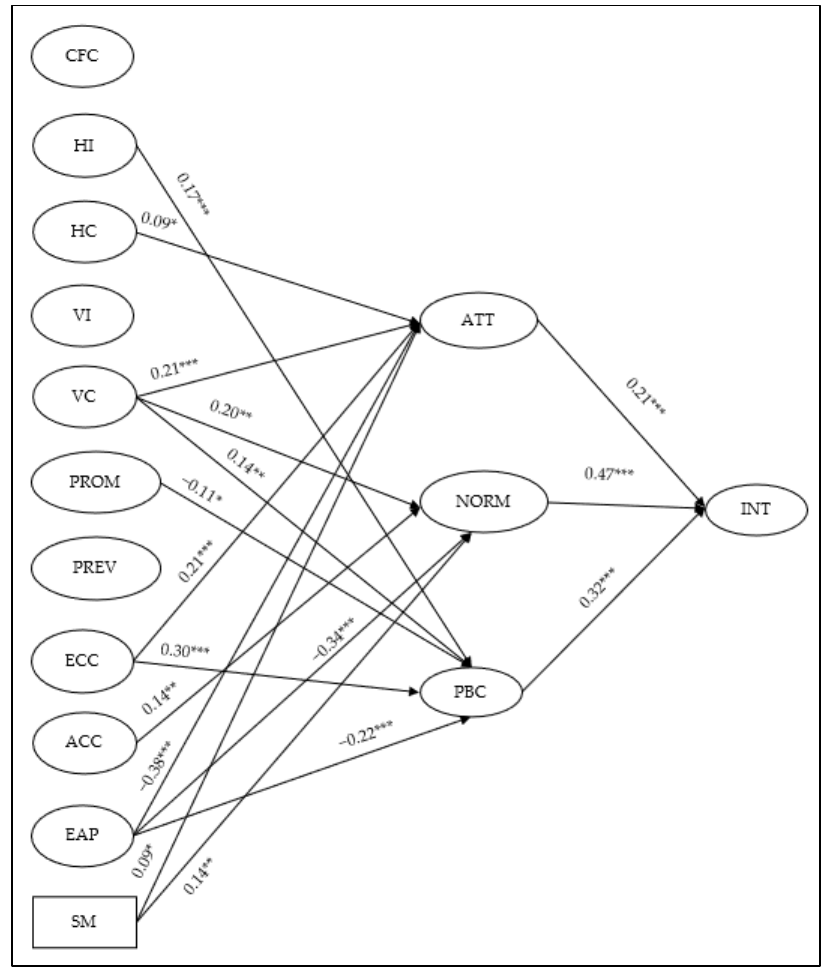
Figure 1. SEM with significant paths. Notes: All shown paths are statistically significant with standardized path coefficients. * indicates significant at 0.05 level; ** indicates significant at 0.01 level; *** indicates significant at 0.001 level. The path coefficients can be found in Table 3. The circles refer to latent variables; the rectangular refers to an observed variable. INT = intention, ATT = attitudes, PBC = perceived behavioral control, HI = horizontal individualism, VI = vertical individualism, HC = horizontal collectivism, VC = vertical collectivism, CFC = consideration of future consequences, PROM = promotion regulatory focus, PREV = prevention regulatory focus, Table 3. SEM path coefficients. ECC = ecocentric, ACC = anthrocentric, EAP = environmental apathy, SM =